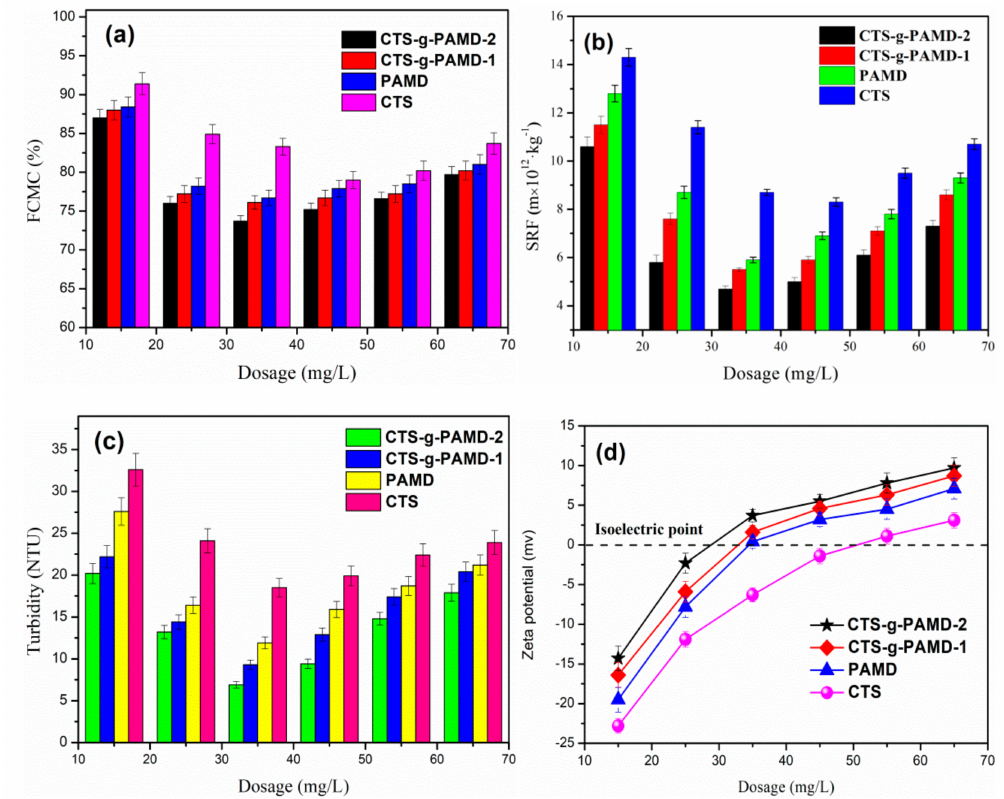
Figure 7. The e ff ect of flocculant dosage on the sludge flocculation performance: ( a ) FCMC, ( b ) SRF, ( c ) turbidity and ( d ) zeta